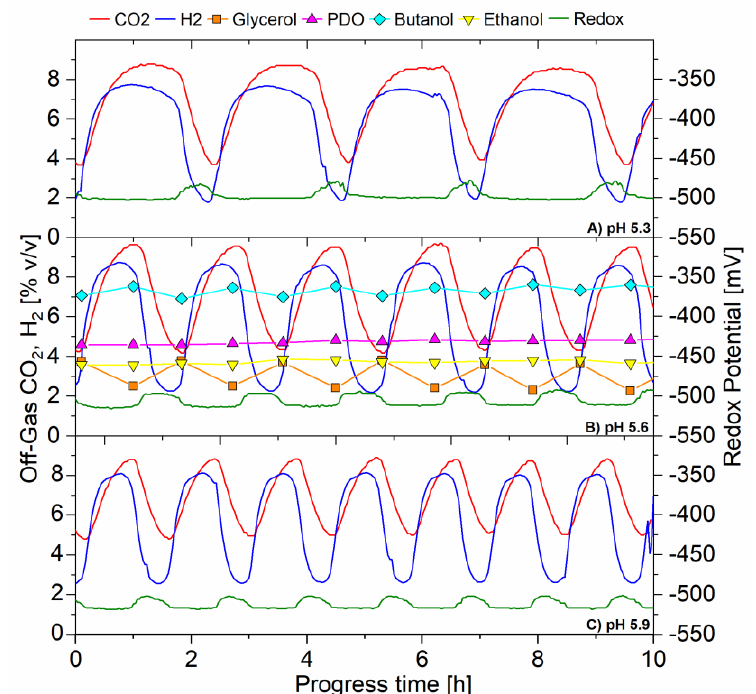
Figure 4. Continuous fermentation showing the effect of pH on the self-synchronized oscillatory metabolism, D = 0.095 h − 1 , feed glycerol 40 g·L − 1 ( A ) 10 h, pH 5.3 ( B ) 10 h, pH 5.6 ( C ) 10 h, pH 5.9. On-line analysis of off-gas (sample frequency 1 min) of: CO 2 (red) and H 2 (blue), % v / v ; redox potential, mV (green). Off-line analysis via HPLC of bioreactor in g·L − 1 of: glycerol (solid orange square); PDO (solid magenta triangle); butanol (solid cyan diamond); ethanol (solid yellow inverted triangle).